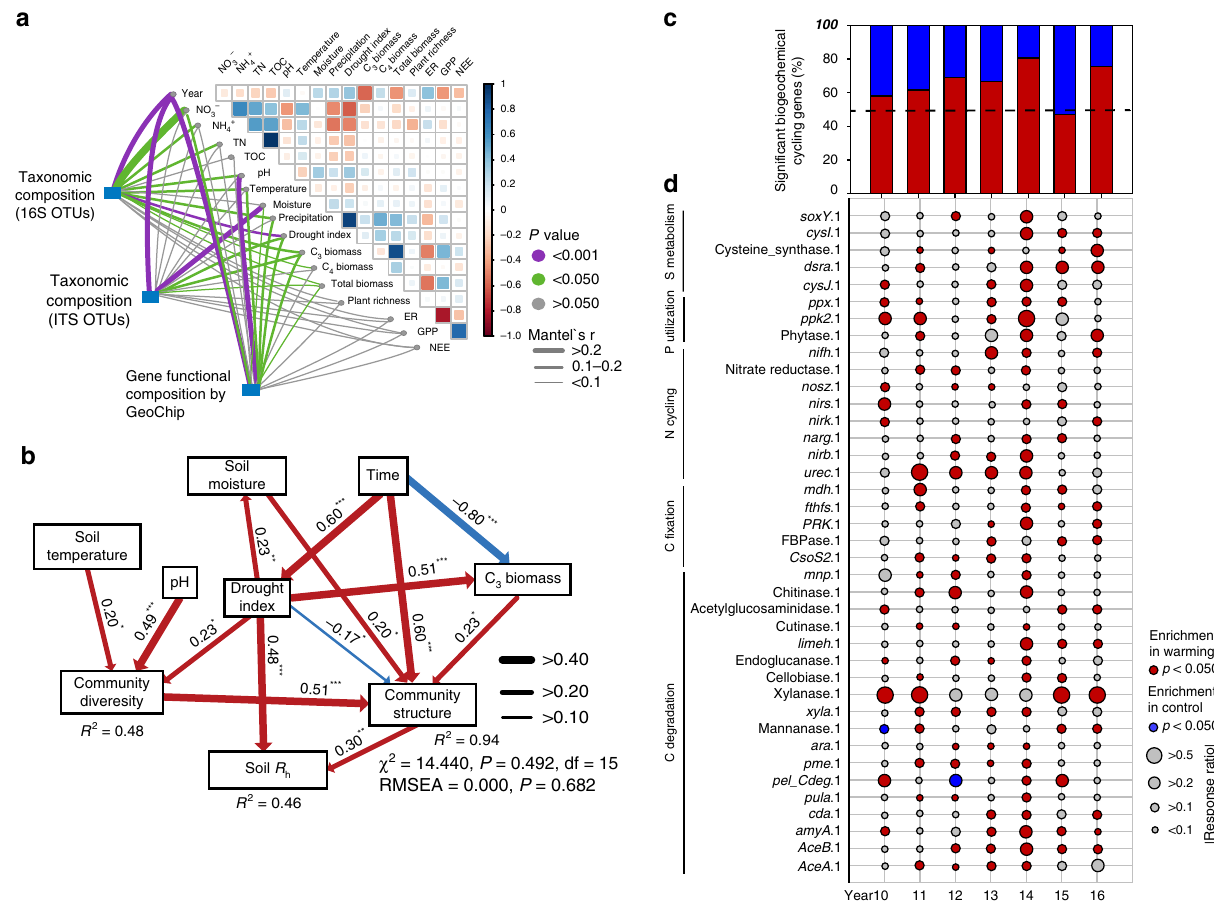
Fig. 2 Feedback mechanisms of soil microbial communities to warming. a Pairwise comparisons of environmental factors with a color gradient denoting Pearson ’ s correlation coef fi cients. Taxonomic and functional community structures were related to each environmental factor by Mantel tests. Edge width corresponds to the Mantel ’ s r statistic for the corresponding distance correlations, and edge color denotes the statistical signi fi cance. b The structural equation model (SEM) showing causal relationships among environmental factors, diversity and structure of microbial functional community, and soil R h . Red and blue arrows represent signi fi cant positive and negative pathways, respectively. Arrow width is proportional to the strength of the relationship and bold numbers represent the standard path coef fi cients. The p values based on 1,000 bootstrapping for path coef fi cients are indicated by *** when P < 0.001, ** when P < 0.01, * when P < 0.05. R 2 indicates the proportion of the variance explained for each dependent variable in the model. c The relative proportion of signi fi cantly warming-stimulated and signi fi cantly warming-inhibited genes in biogeochemical cyclings according to GeoChip data. Dash line represents that the abundance of warming-stimulated (red) genes are equal to the abundance of warming-inhibited (blue) genes. Signi fi cance is based on response ratio of each gene with 95% con fi dence intervals. Biogeochemical cycling genes included all genes involved in C degradation, C fi xation, N cycling, phosphorus (P) utilization and sulfur (S) metabolism. d Bubble plot illustrating the enrichment of key biogeochemical cycling genes under warming (W) and control (C) treatments according to GeoChip data. Bubble color represents the signi fi cance ( p -value) of gene enrichment based on response ratios. Bubble size represents the relative changes of gene enrichment based on response ratios. The biogeochemical cycling processes for these genes are shown in plot, and the full names of the genes in this plot are listed in Supplementary Table